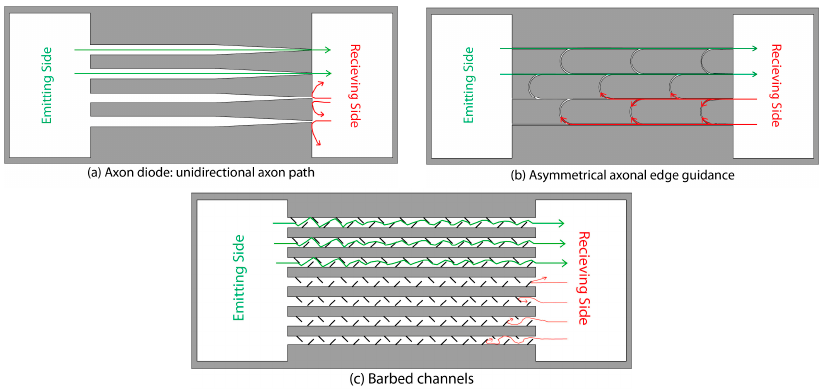
Figure 3. Different methods of forming uni-directional axonal path linking emitting neuronal population to receiving neuronal population in confinement devices. Green lines indicate allowed axonal growth and red lines indicate blocked axonal growth. ( a ) Channels with varying widths block most axonal growth from the narrow side and allow axonal growth from wide side. Adapted from [56] with permission of The Royal Society of Chemistry; ( b ) Asymmetric axonal edge guidance directs axons from the receiving end back through the bypass curved channels, effectively blocking their forward growth. Axons originating from the emitting side are not affected by bypass